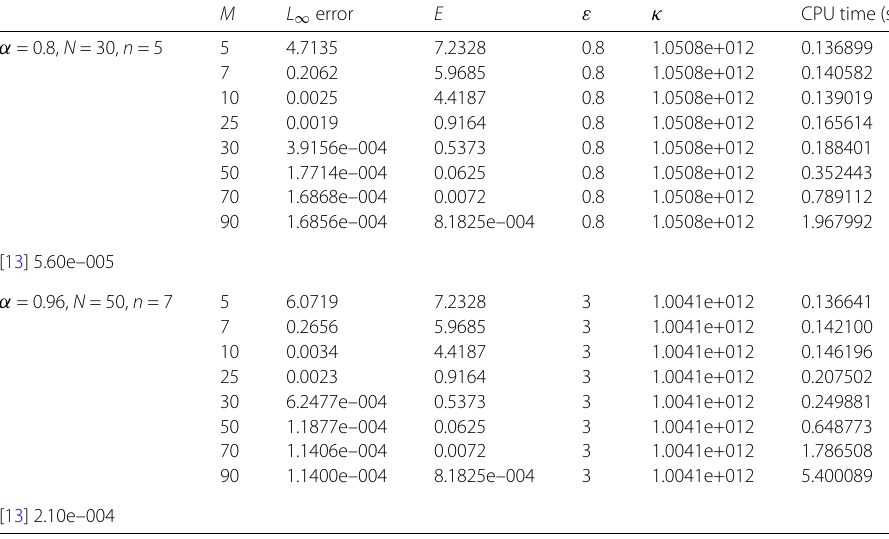
Table 1 The maximum absolute error in our method and in [13] corresponding to Problem 1 M L ∞ error E ε κ CPU time (s) α = 0.8, N = 30, n = 5 5